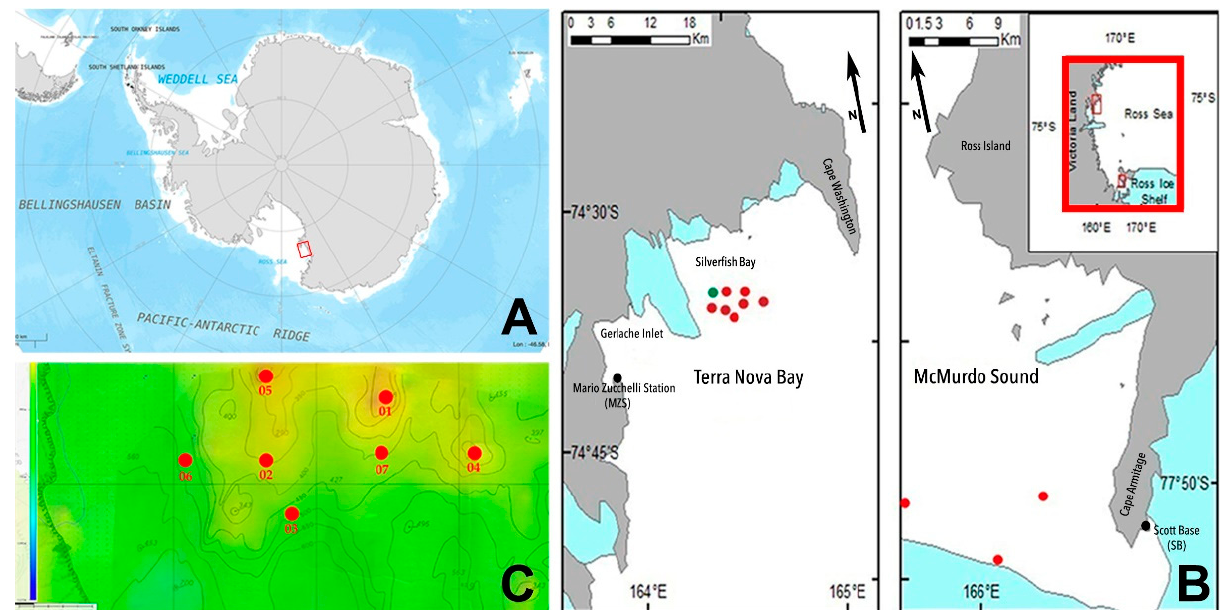
Figure 1. The study area. (A) Location of the study area within Antarctica continental shelf (red frame); (B) Sampling sites at Terra Nova Bay (left) and McMurdo Sound (right). Ice tongues or ice shelves are marked in light-blue colour; lands are marked in grey; white colour corresponds to seawater, partly covered by sea ice during the sampling periods. The sampling stations are in areas covered by fast ice in the late spring. Red dots indicate the sites sampled in 2018 at Terra Nova Bay (left) and in 2015 at McMurdo Sound (right). The green dot corresponds to the sampling site at which the BRUV was opportunistically deployed in 2017, three times with the bait and two times without the bait. (C) Bottom geomorphology at Silverfish Bay (Terra Nova Bay), the red dots are the seven sampling sites where Baited Remote Underwater Video camera (BRUV) deployments were carried out in 2018.